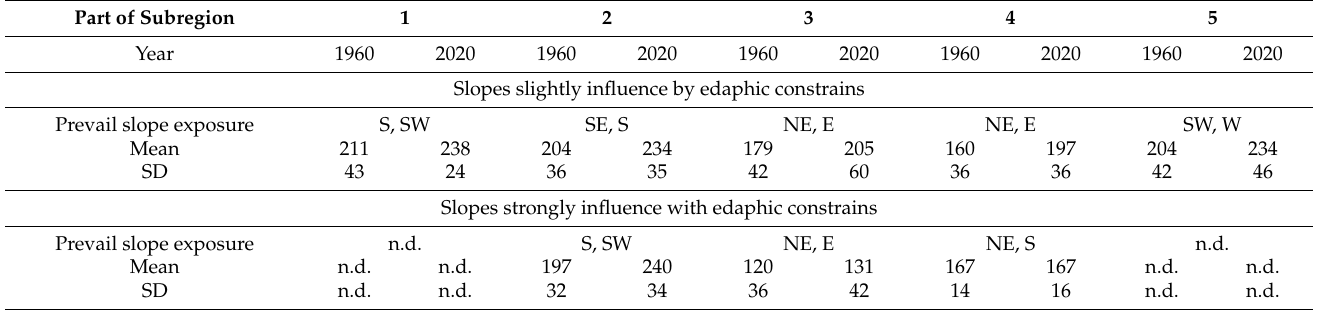
Table 7. Altitudinal position of the open forest boundary (mean and SD) on prevailing slope exposures at different parts of the studied subregion of Polar Urals in 1960 and